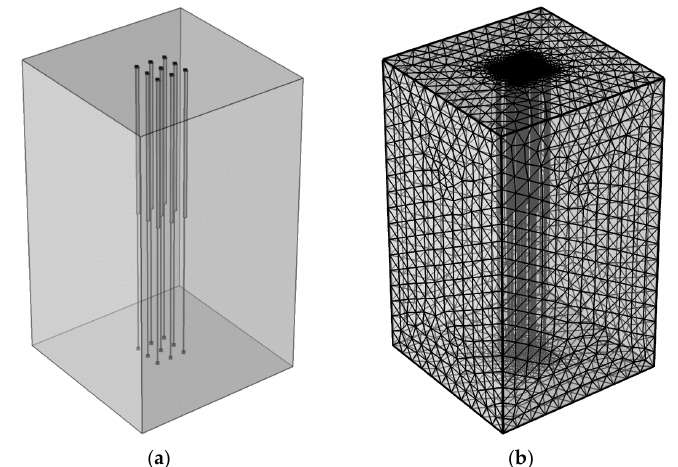
Figure 8. ( a ) The geometry model, ( b ) The mesh distribution of squared arrangement.